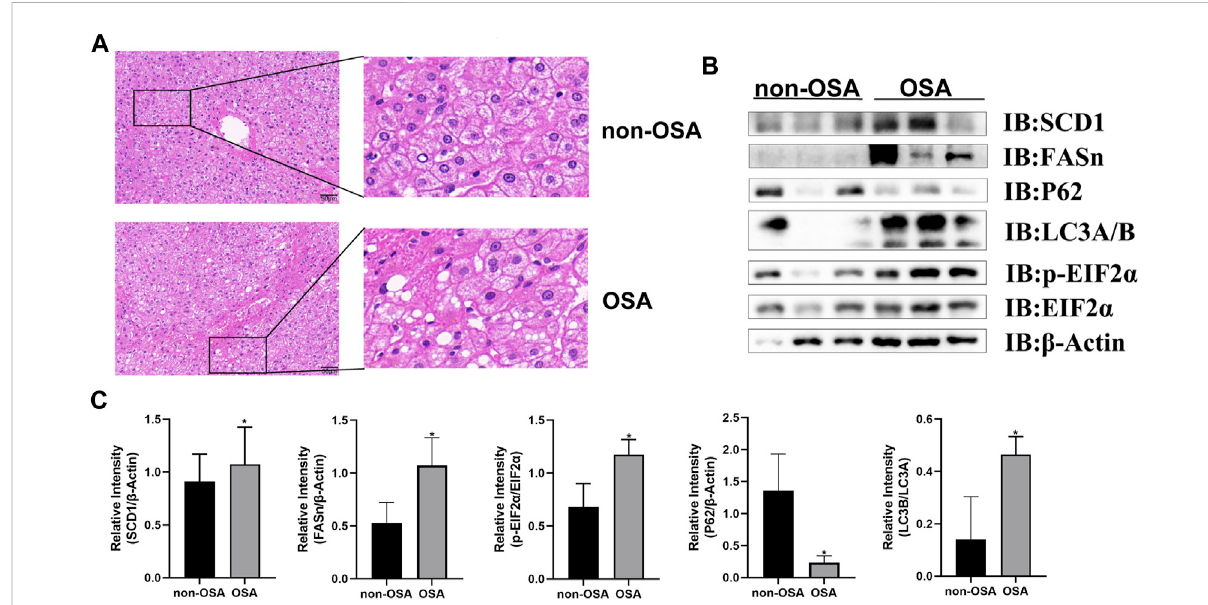
FIGURE 1 OSA patients exhibit increased hepatic steatosis and elevated levels of hepatic proteins associated with autophagy, ER stress, and lipogenesis. (A) H&E stainingoflivertissue samplesfrompatients withandwithoutOSA(Scalebars:100and50 μ M). (B) HepaticFASn,p62, LC3A/B,and p-EIF2 α